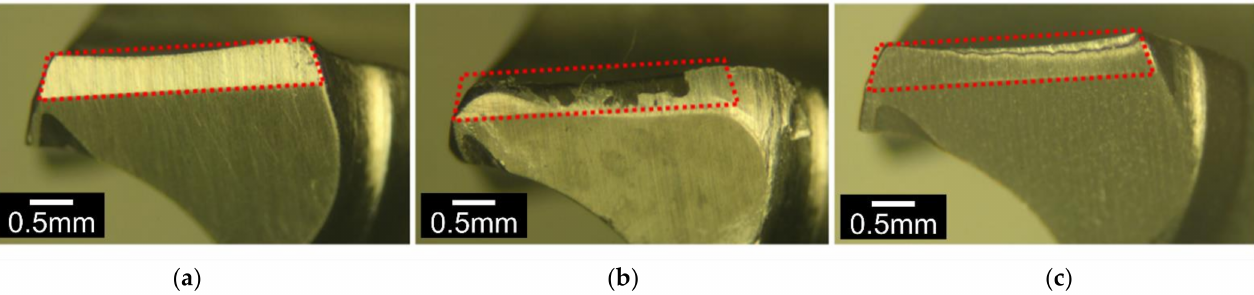
Figure 10. Optical images of cutting-edge areas of the pins: ( a ) as received new pin, ( b ) untreated, and ( c ) C3T660-5PdAg treated pins after insertion test with SAWBONES®cortical bone